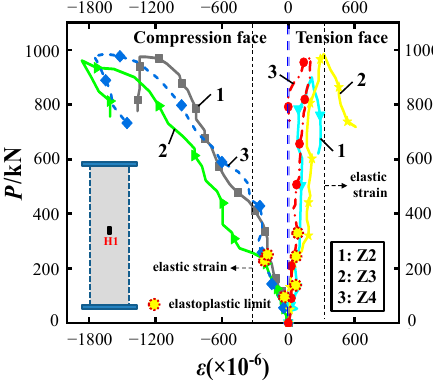
Figure 13. Load–strain curve of concrete.